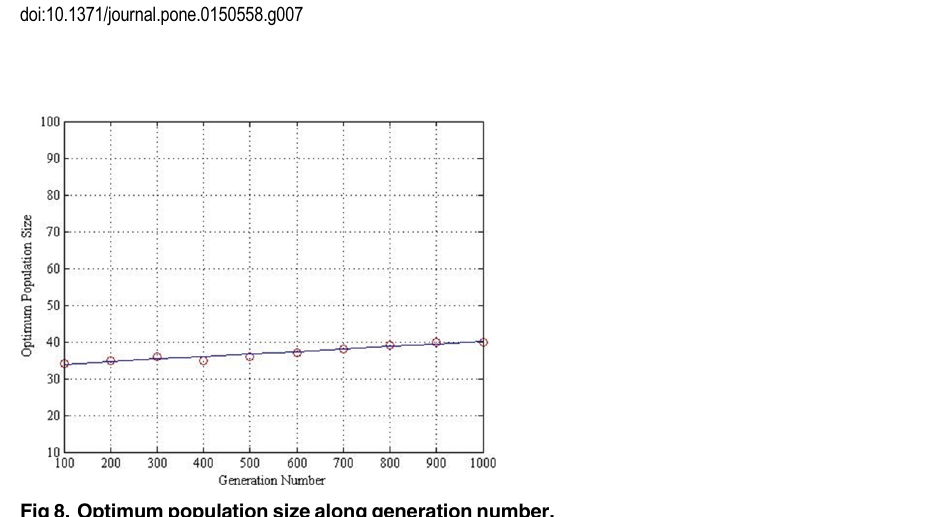
Fig 8. Optimum population size along generation